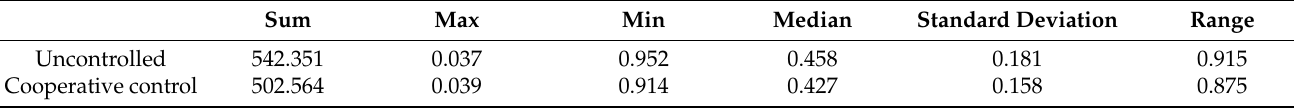
Table 10. Turnover results.